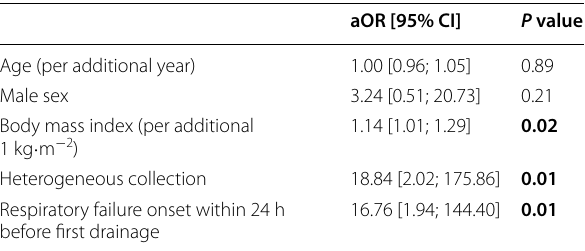
Table 3 Multivariate analysis to identify predictors of catheter drainage